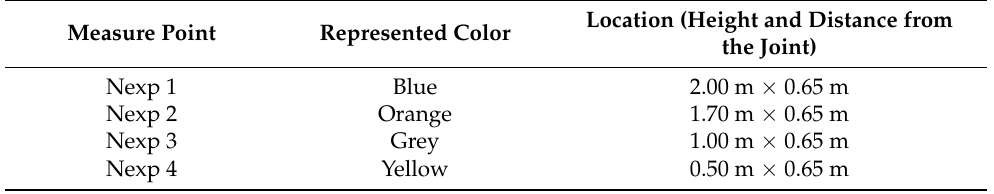
Table 6. Reference test points at the treated area.